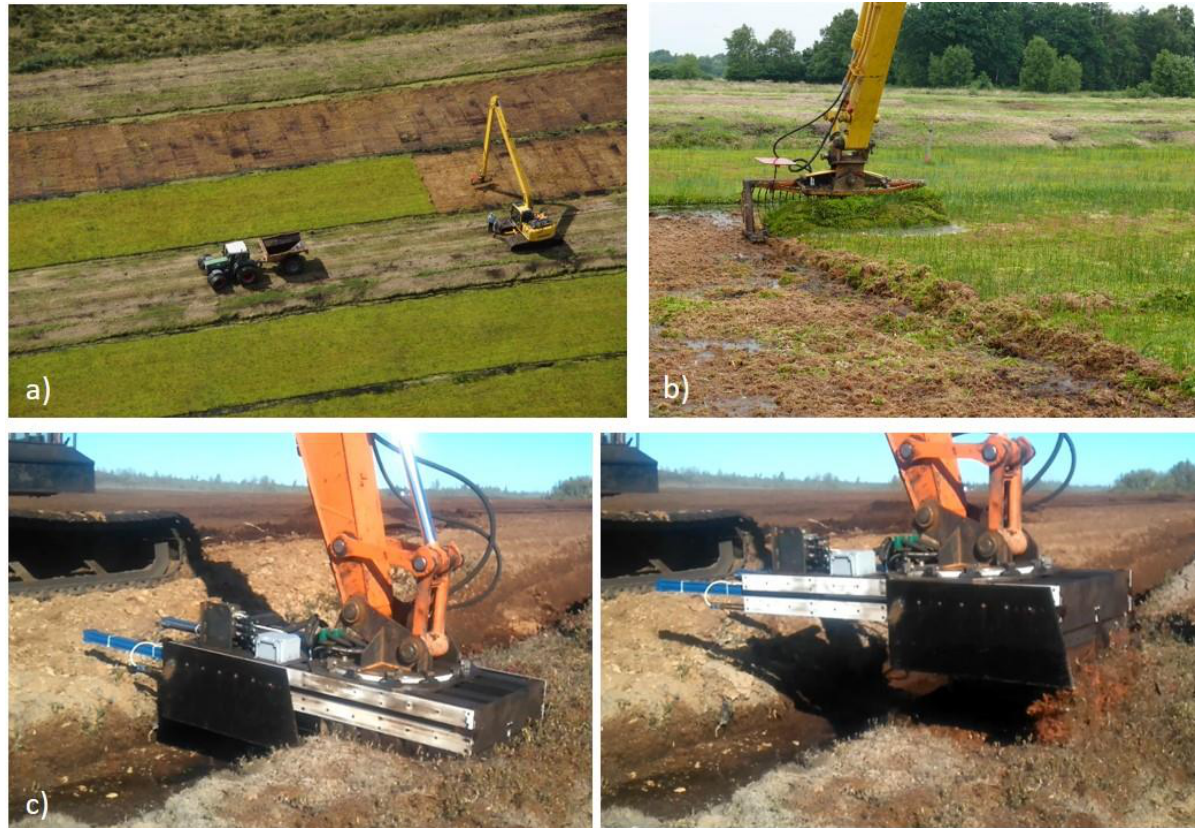
Figure 7. Harvesting techniques for Sphagnum farming using a) an excavator operating from a causeway, equipped with b) a mowing bucket or c) a modified excavator for block-cut peat extraction, which tests in Canada have shown can also harvest Sphagnum . Photos: a) Gerd Block, b) Sabine Wichmann and c) Benoit